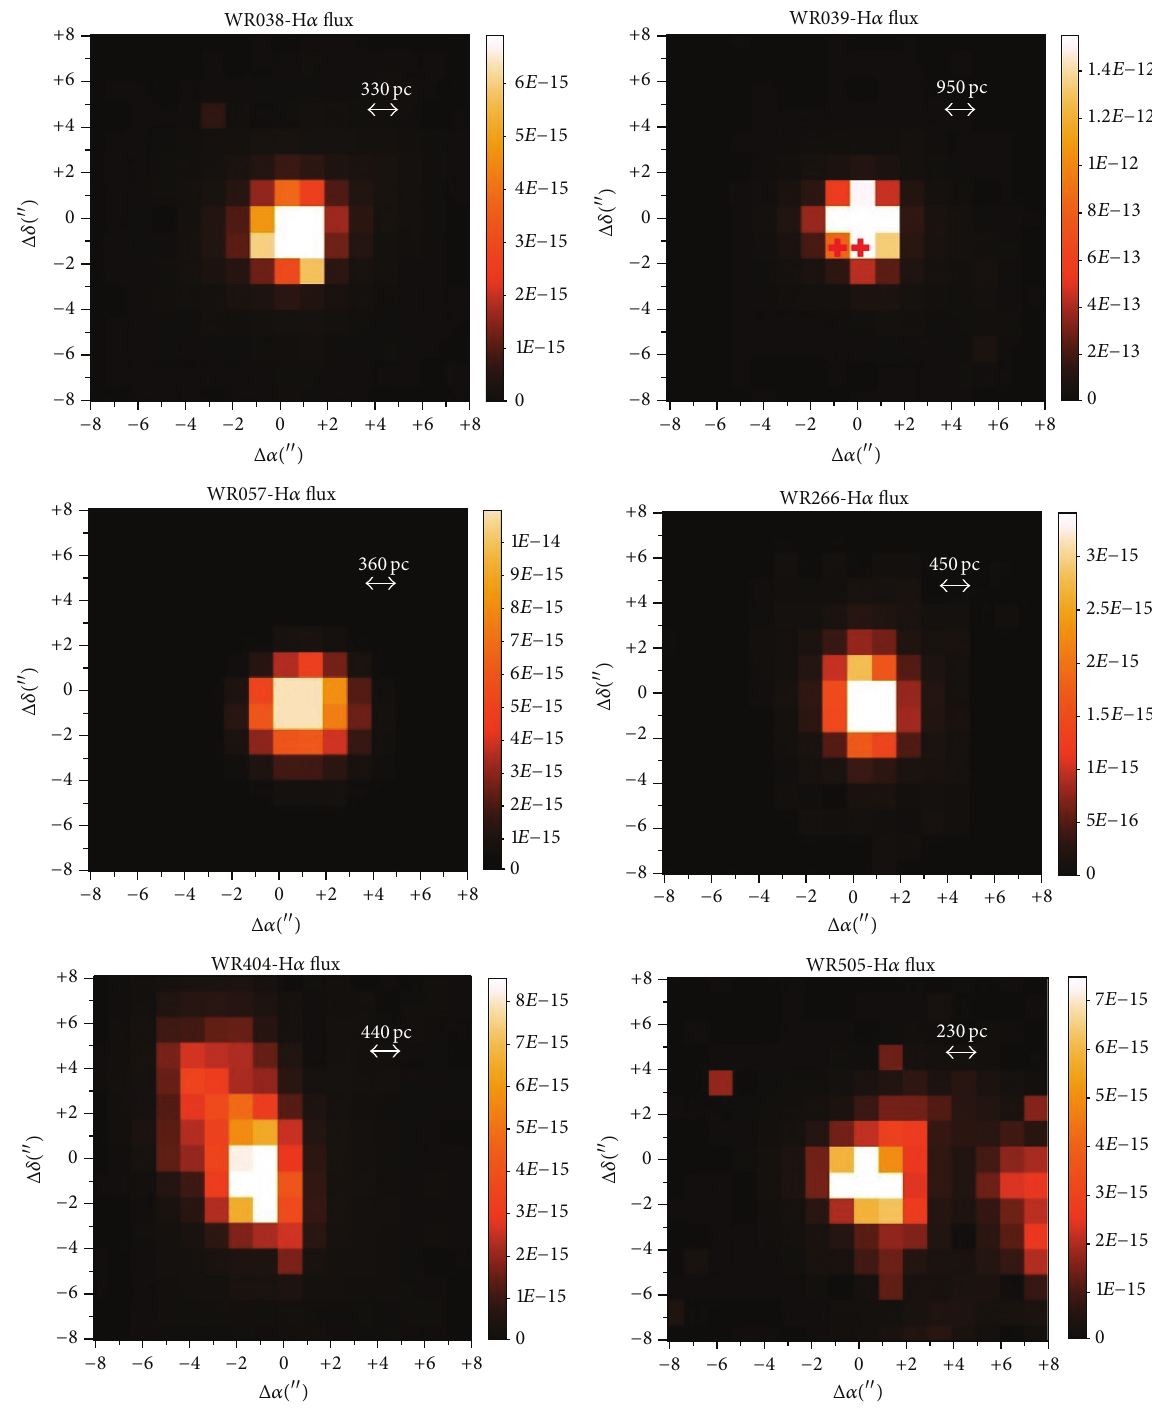
Figure 1: Extinction corrected H 𝛼 maps of the six observed WR galaxies. In all images, each spaxel has 1 󸀠󸀠 of resolution. North is up, and east is to the left. Fluxes are in units of erg/s/cm 2 . The relative size in parsecs, at the adopted distance of each object, is indicated. For WR038, the spaxels where the WR bump was detected from our PMAS data are marked with red